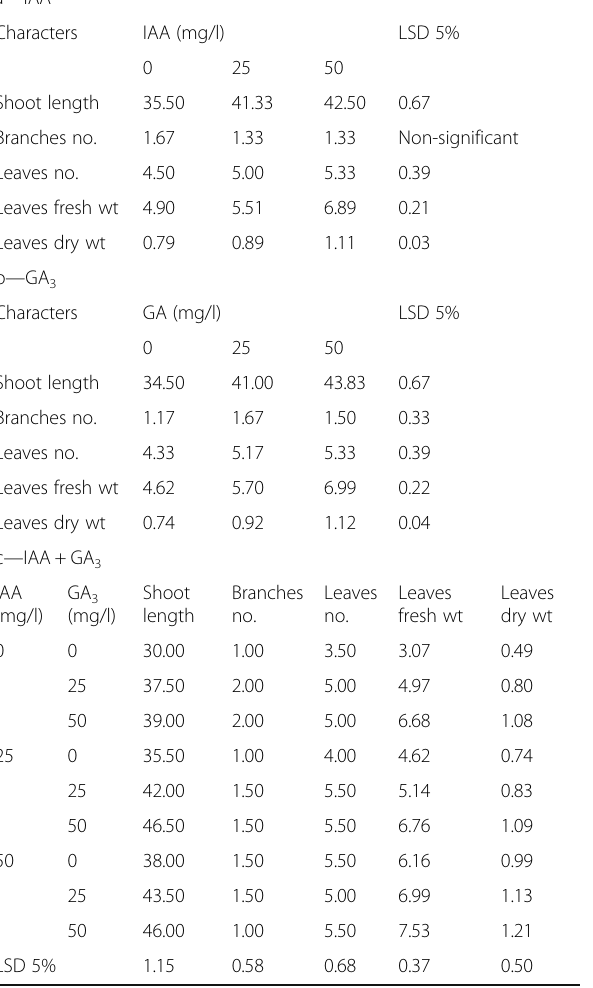
3 (b), and IAA + GA 3 (c) (0,